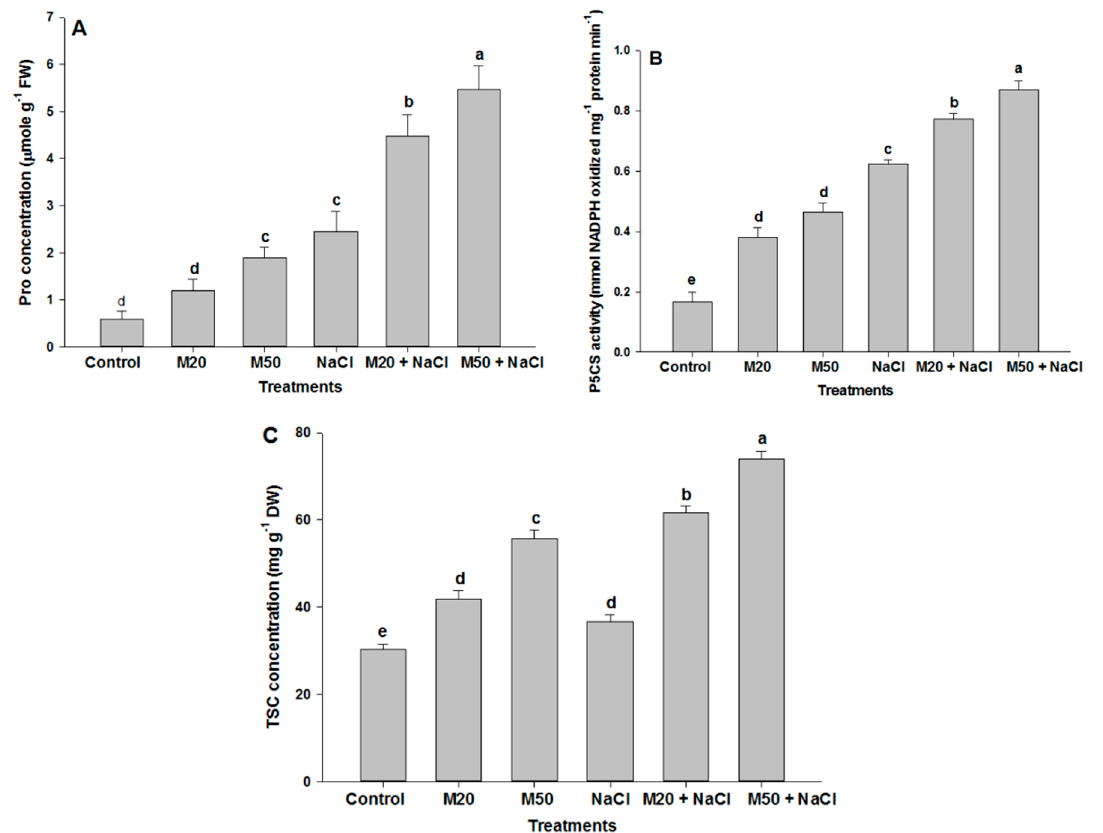
Figure 7. E ff ect of melatonin on ( A ) proline (Pro) content, ( B ) Pyrroline-5-carboxylate synthase (P5CS) activity and ( C ) total soluble carbohydrates (TSC) content in leaves of tomato seedlings under salinity. Data represent mean of 4 replicates with bars indicating SE. The bars labelled with di ff erent letters are significantly di ff erent at p < 0.05%. [DDW (control), 20 µ M melatonin (20M), 50 µ M melatonin (50M), 100 mM NaCl (NaCl)].